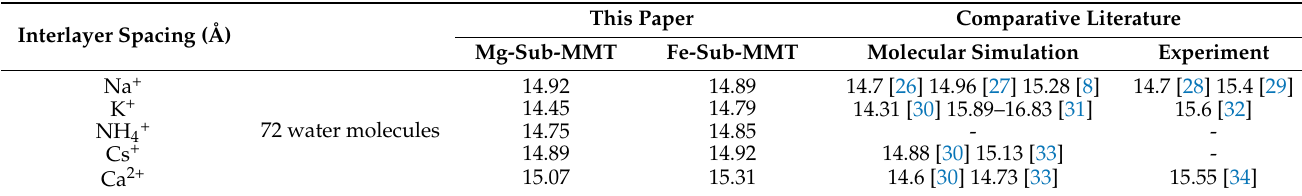
Table 3. Interlayer spacing of MMT under different inhibitory